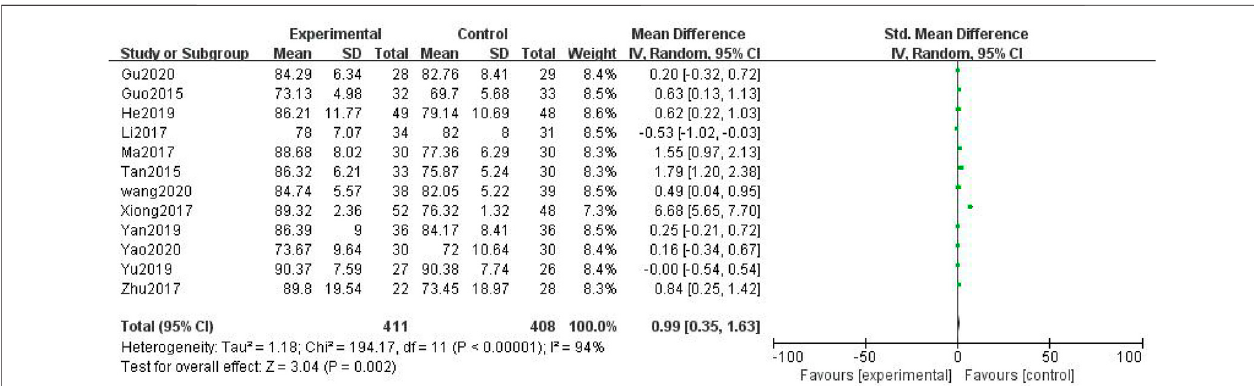
FIGURE 8 | Karnofsky performance score.